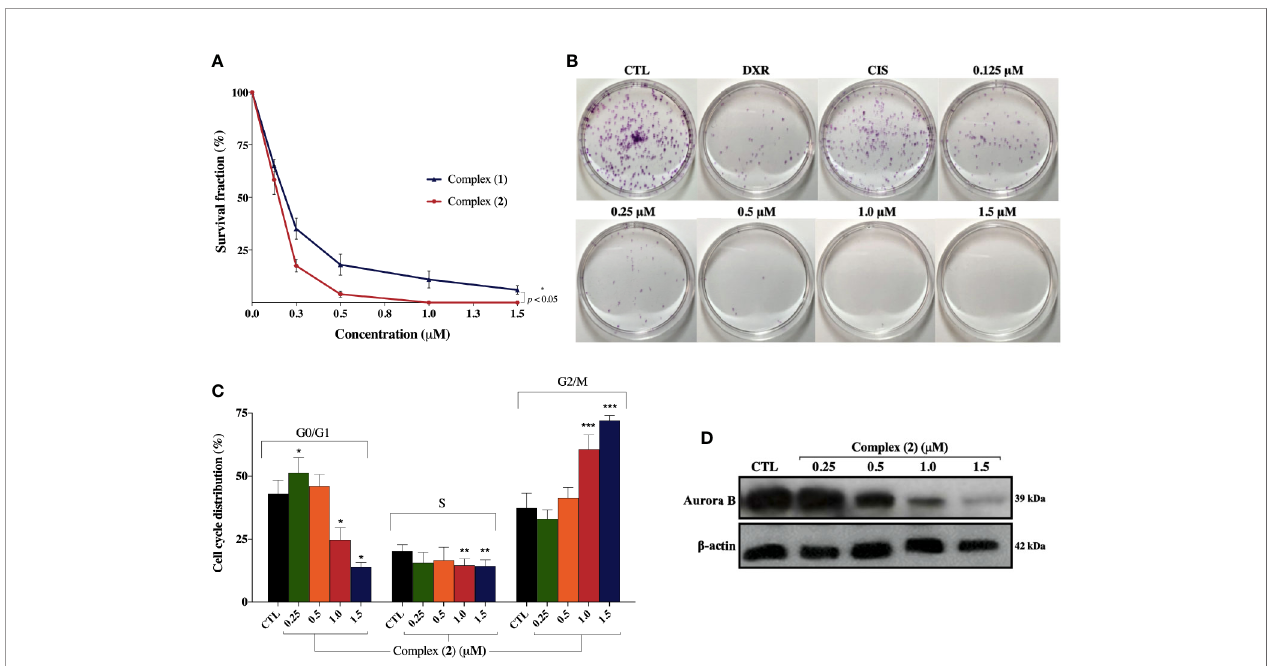
FIGURE 3 | Effect of lapachol-containing ruthenium complexes in DU-145 cell proliferation and cell cycle kinetics. (A) The survival fractions after 24h treatment with 0.125; 0.25; 0.5; 1.0, and 1.5 m M of complexes ( 1 ) and ( 2 ) against DU-145 cells. (B) Representative colony formation images of DU-145 cells after treatment with different concentrations of complex ( 2 ), DXR (2.5 m M) and CIS (25 m M). (C) Cell cycle distribution of DU-145 cells after treatment with complex ( 2 ) for 24 h. *, **, and *** indicate signi fi cant difference compared to the CTL in phase G0/G1, S, and G2/M, respectively. (D) Western blot analysis showing the expression status of Aurora-B in prostate adenocarcinoma cells after treatment with complex ( 2 ) for 24 h. The densitometric analysis of gray bands is shown in Supplementary Figure 11 . The negative control (CTL) was treated with the vehicle (DMSO 0.1% v/v) used for diluting the complex. Data are presented as the mean ± S.E.M. of three independent experiments performed in duplicate. Two-way ANOVA followed by Dunnett ’ s post-test ( p <